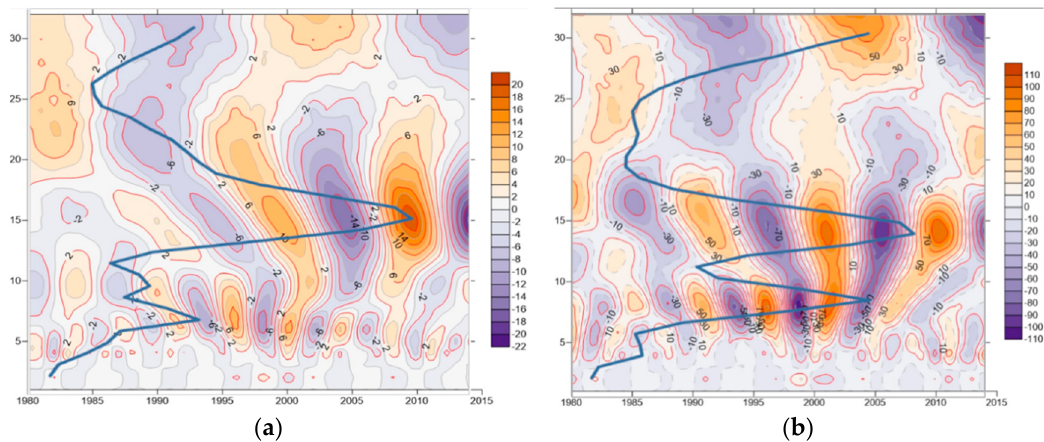
Figure 6. The real part of Morlet wavelet transform coefficient and the wavelet variances at CHUMPHON (CH) ( a ) and UBON (UB) ( b ) stations.